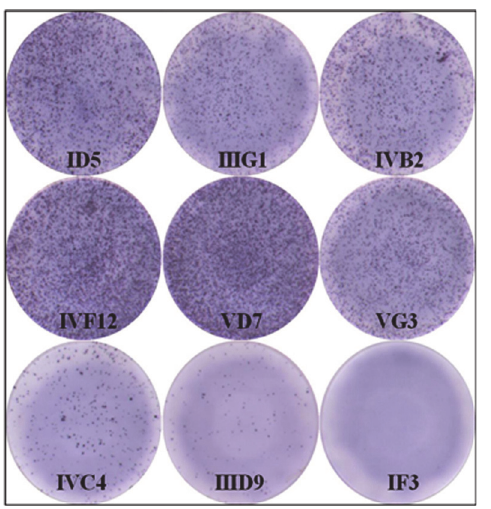
Figure 2. Confirmation and cloning of PrP BSE -infected cells. The presence of proteinase K resistant PrP BSE in 96 well elispot plates was confirmed by using scrapie cell assay (SCA). The photograph showed severe (ID5, IIIG1, IVB2, IVF12, VD7 and VG3), moderate (IVC4), weak (IIID9) and non-infected (IF3) wells. These data shown are representative of results from ELISA and Western blot.